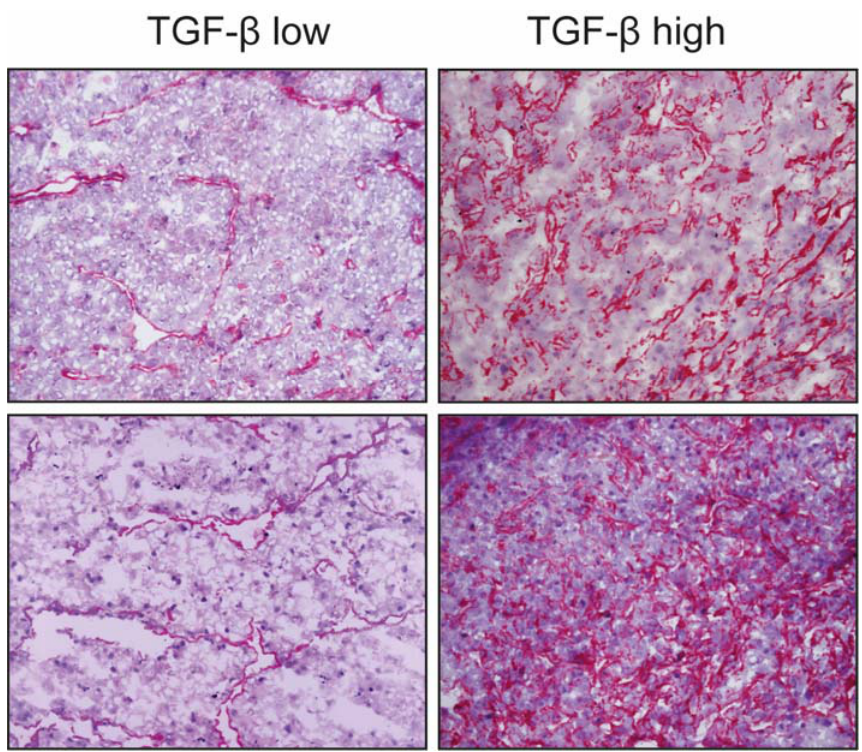
Figure 3. Expression of transforming growth factor ‐β (TGF ‐β ) in 4 HCC samples. Overall staining is evident, with a preferential sub ‐ endothelial localization, possibly perisinusoidal, especially in tissues with lower expression. The cytokine delivery sites appear to be closely associated to parenchymal cells in HCC nodules. Representative images at 10×.